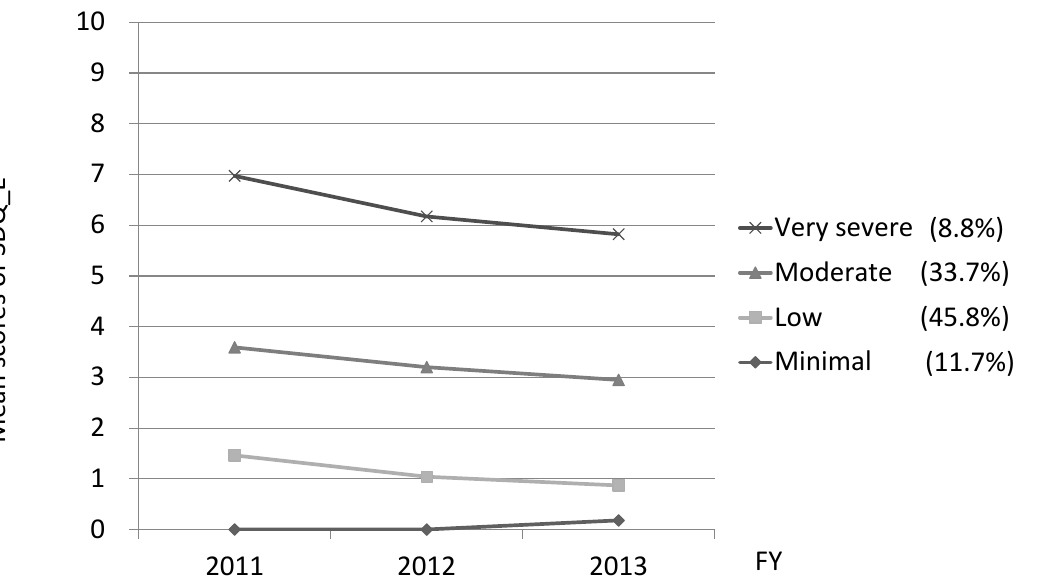
Figure 1. Trajectories of the four-group model of emotional symptoms. The mean scores of emotional symptoms of the four-group (very severe, moderate, low, minimal), using semi-parametric group-based modelling.